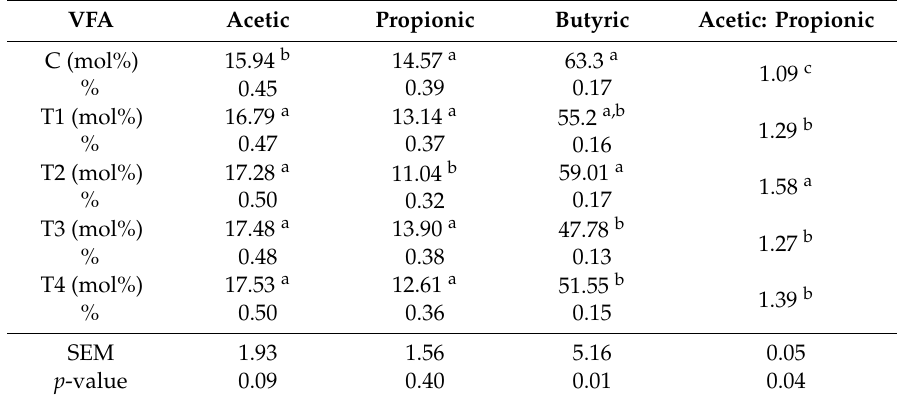
Table 3. The e ff ect of dietary treatment on ruminal volatile fatty acid concentrations (mol%). VFA Acetic Propionic Butyric Acetic: